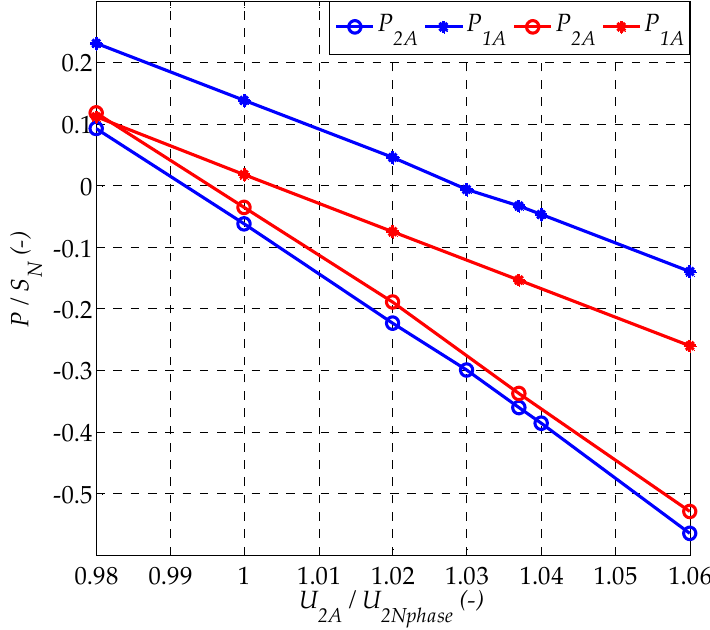
Figure 1. Amplitude control of active power P 1A and P 2A at φ 2A = 0 (blue line — R load, red line — RL load, p.f. = 0.8).